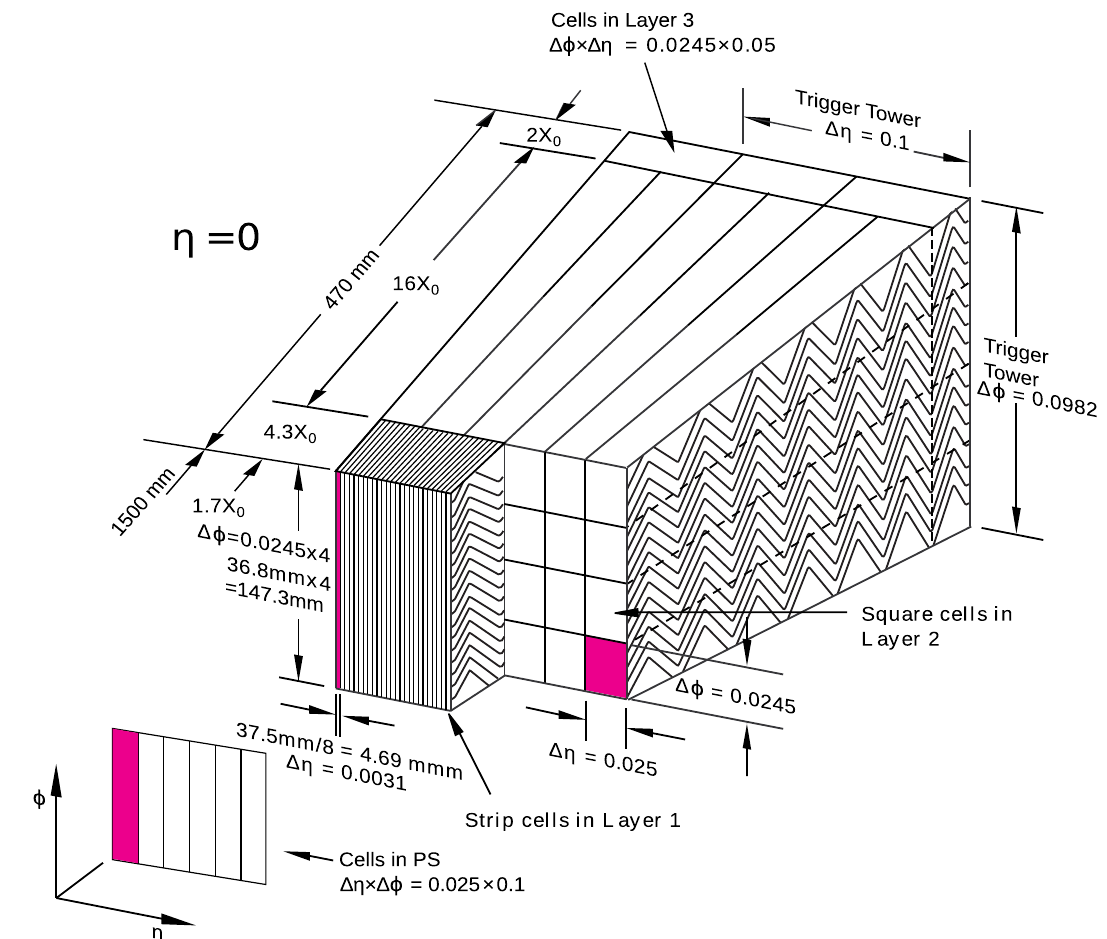
Fig. 1 Sketch of the lateral and longitudinal segmentation of the ATLAS electromagnetic calorimeter around η = 0